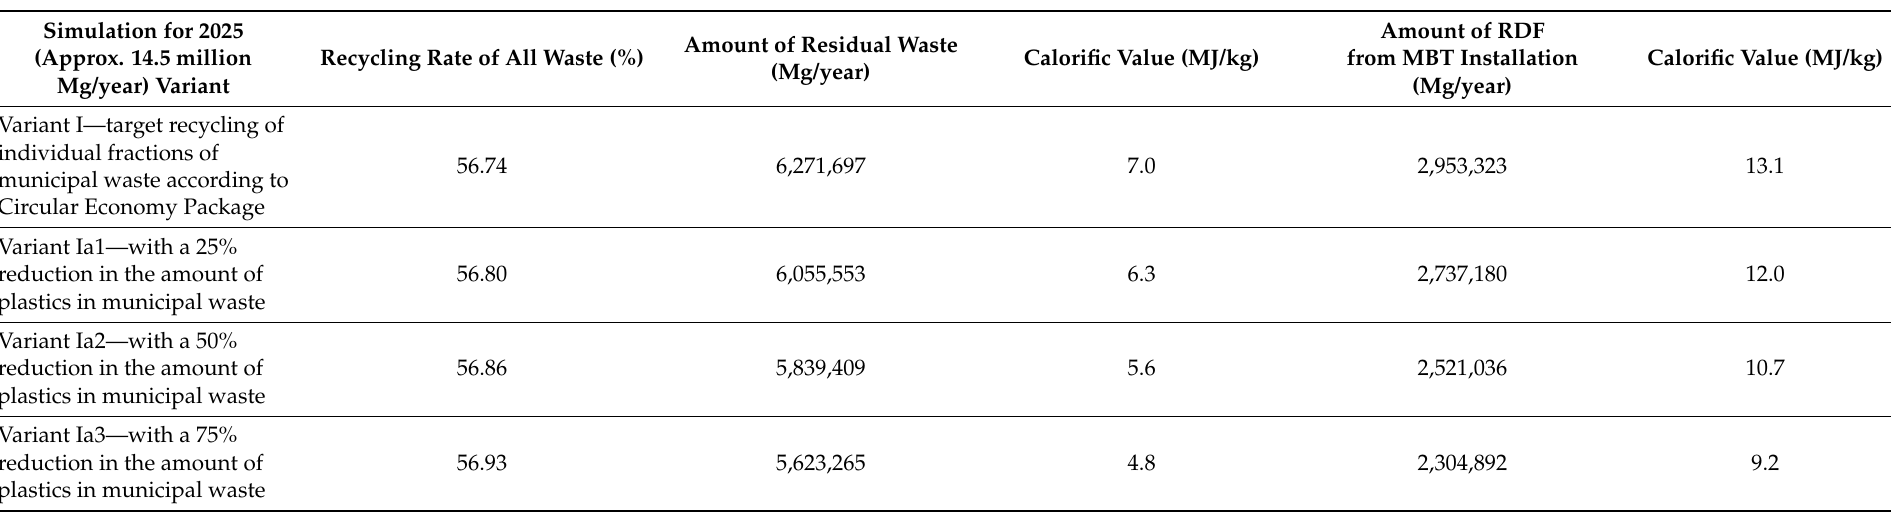
Table 11. The amount and calorific value of residual waste and the calorific fraction for various implementation variants of the Circular Economy Package—the impact of reducing the amount of plastics in municipal